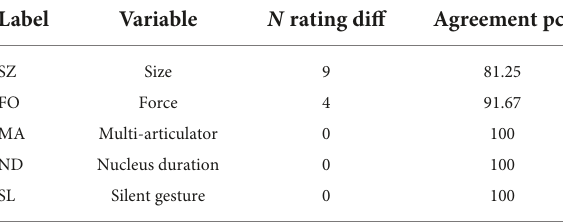
TABLE 2 Agreement rates for parameters of Gesture Expressivity Index (GEI); all parameters except ND (Nucleus duration), which was computed mathematically from the durations of the stroke and, if available, hold phases, were rated by two independent